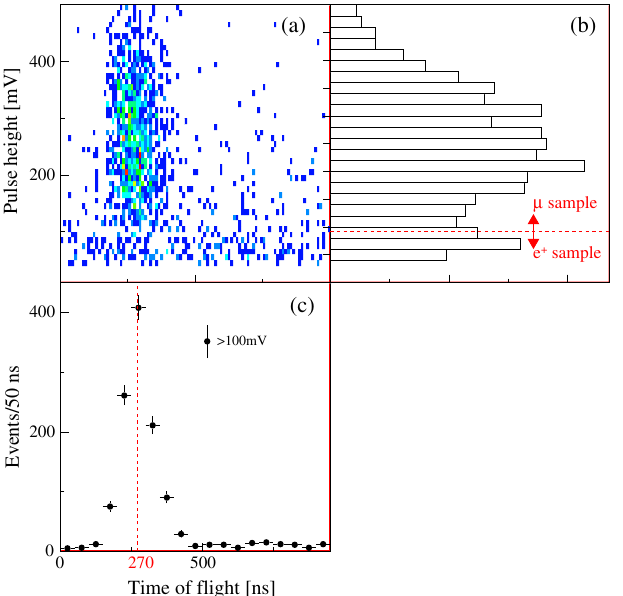
FIG. 3. Distribution of the MCP pulse height and the TOF of the penetrating μ þ . (a) Scatter plot of the pulse height vs TOF. (b) Pulse height of the MCP signal. The events above 100 mV were regarded as μ þ . (c) TOF spectrum after the pulse-height cut was applied. The peak corresponds to the μ þ ’ s injected into the RFQ with an energy of 89 keV.